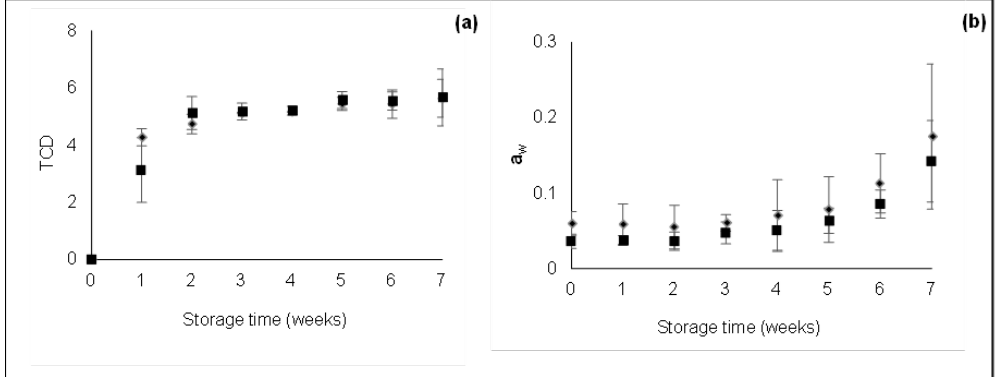
Figure 1. TCD ( a ) and a w ( b ) of non-ozonized ( ⧫ ) and ozonized ( ◼ ) dried peels during storage. Data represent mean values and bars represent the limits of confidence intervals at 95%.